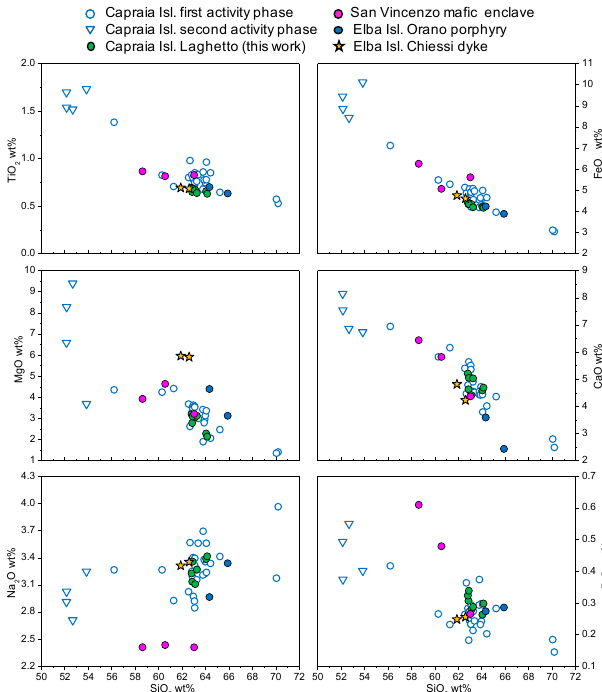
Figure 5. Major element variation diagrams for Capraia rocks. Geosciences 2020 , 10 , x FOR PEER REVIEW